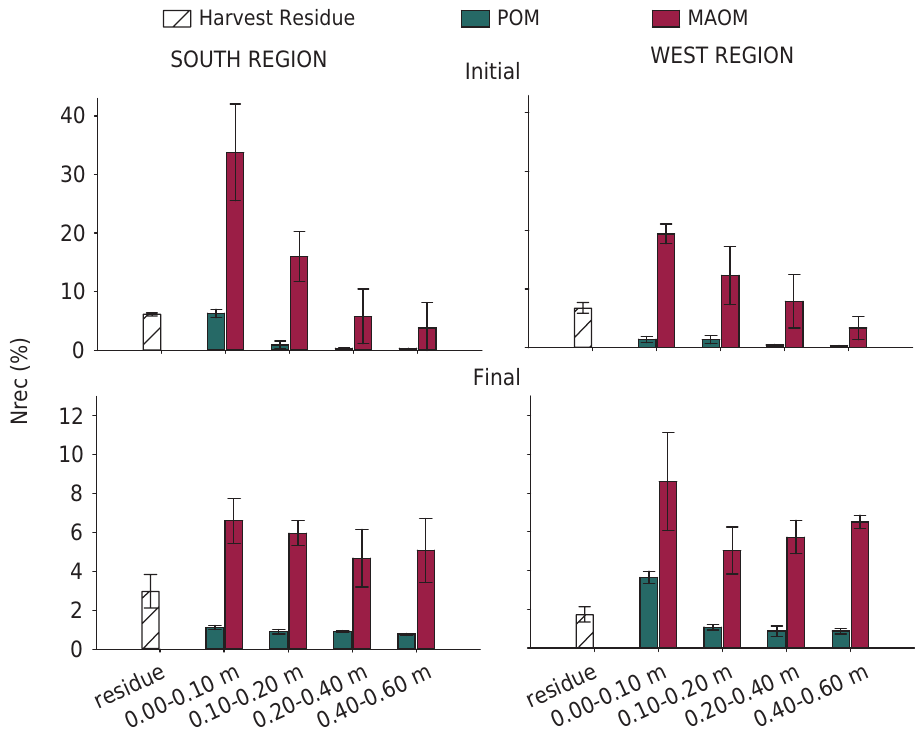
Figure 5. Recovery of nitrogen fertilizer (Nrec) in harvest residues, particulate organic matter (POM), and mineral-associated organic matter (MAOM) soon after application of 50 kg ha -1 (initial) and at 36 months (final). Bars in each column represent standard deviation of the means.